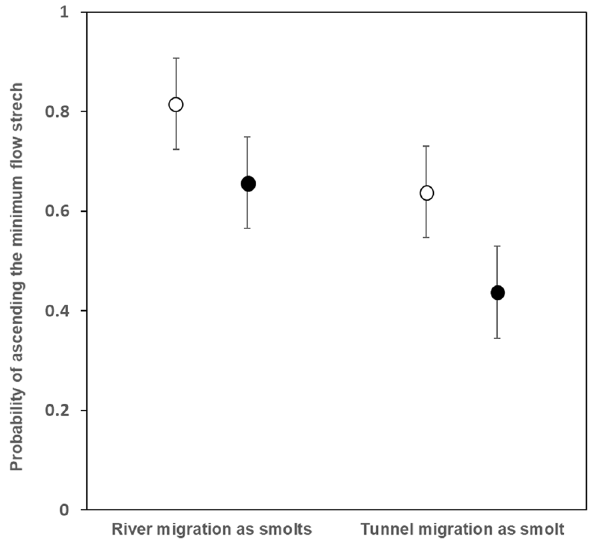
Figure 2. Predicted Atlantic salmon spawners probability to ascend through the minimum flow stretch in River Nidelva for individual river and tunnel migrants as smolts as a function of number of years at sea before returning to spawn (1SW:white points, 2SW black points, with standard error) to River Nidelva derived from the selected binomial GLM reported in Table 2.